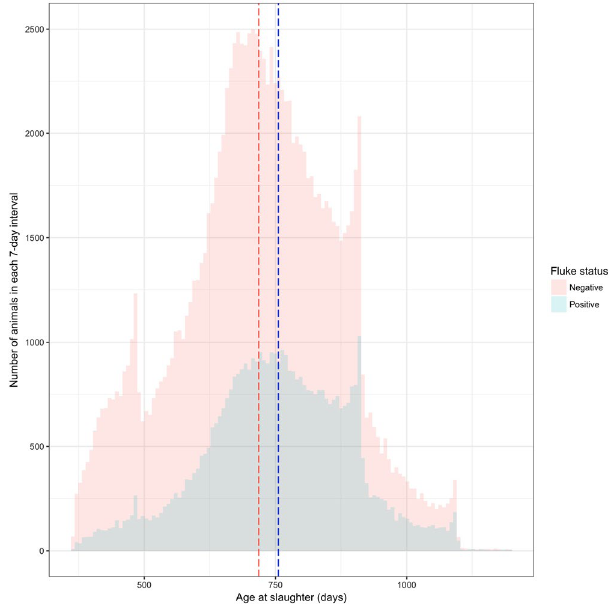
Figure 1. Distribution of age of cattle at slaughter by liver fluke status. This figure compares the age distribution at the time of slaughter between animals who had livers rejected due to signs of liver fluke infection and those who did not using data from the two year abattoir dataset (n = 169,605). Dotted lines show the mean ages at which fluke negative (red) and fluke positive (blue) cattle are slaughtered. There is a 37 days difference between the two